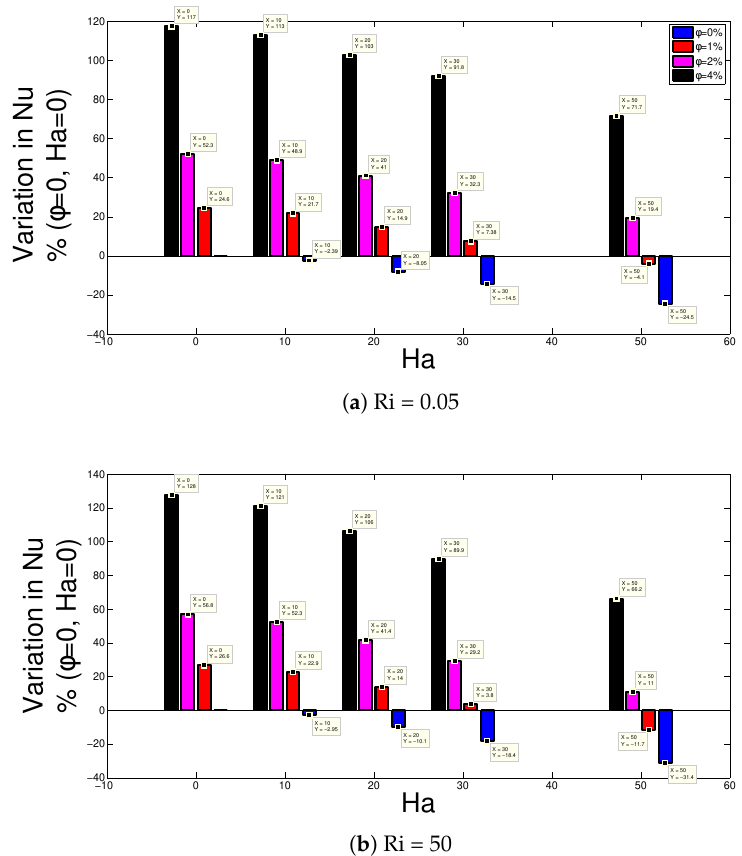
Figure 6. Enhancement in the average Nusselt number with respect to changes in φ and Hartmann number considering Richardson number of 0.05 ( a ) and Richardson number of 50 ( b ) (Da = 10 − 3 , AR = 0.25, x 0 = 0.5